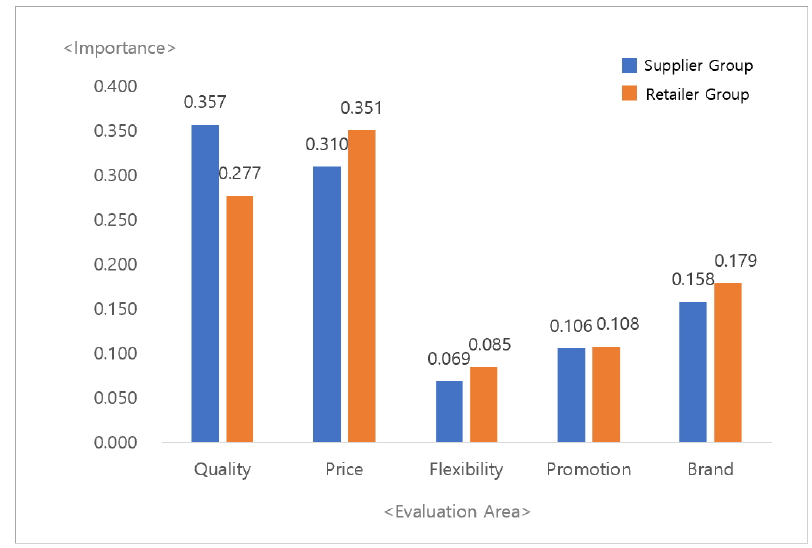
Figure 4. Comparison analysis result of evaluation areas.